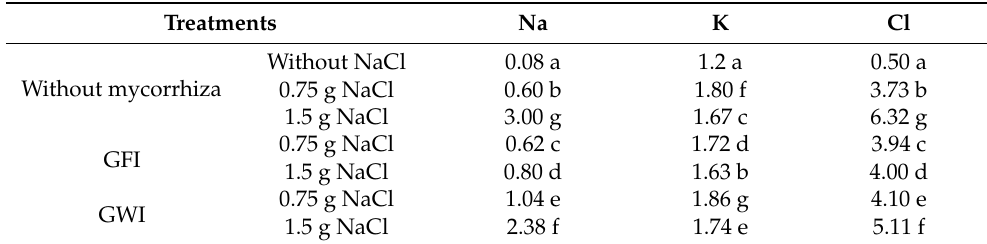
Table 7. Accumulation of saline ions in roots of Persea americana var. Zutano inoculated with Glomeromycota fungi (GFI and GWI) under salinity stress conditions. Treatments Na K Cl Without NaCl 0.34 a 0.96 f Without micorriza